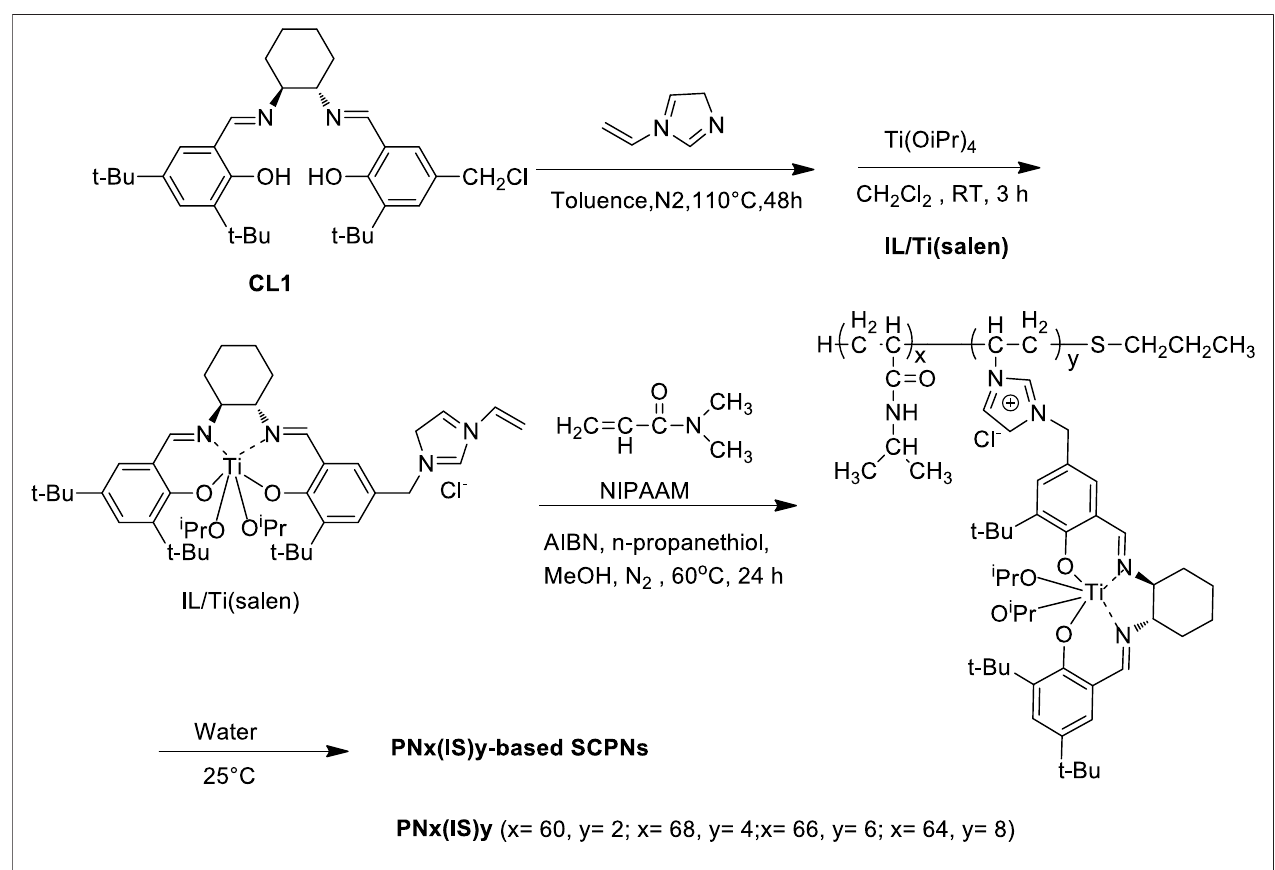
SCHEME 5 | Schematic representation of synthesis and self-folding of PN x (IS) y (Zhang Y et al., 2017).